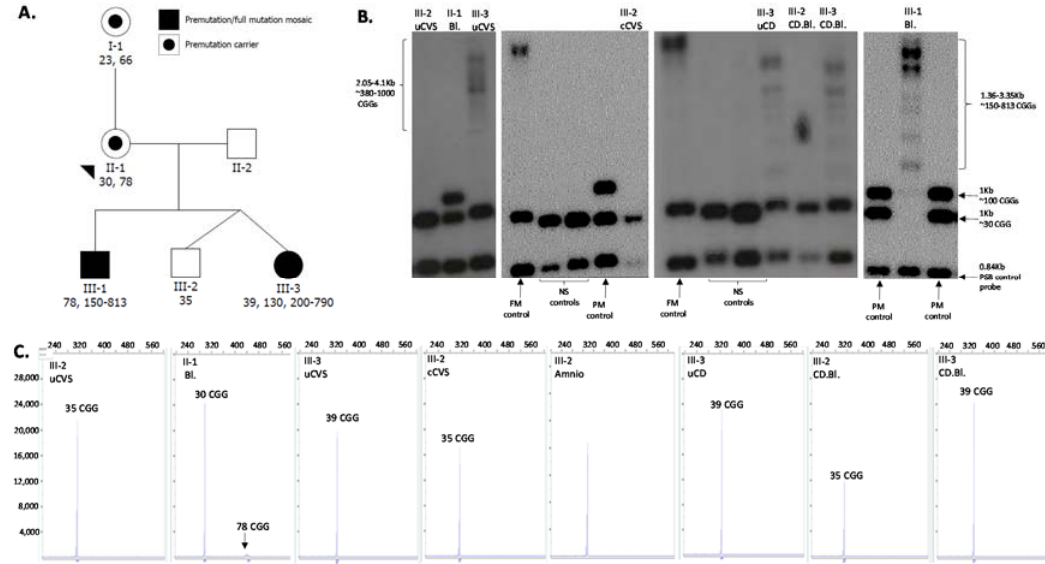
Figure 1. Pedigree and sizing of the CGG repeat using Southern blot and PCR. ( A ) Pedigree of the studied family with squares and circles symbolising males and females, respectively. CGG size is indicated by numbers below each participant’s ID (determined on postnatal tissues); ( B ) Southern blot analysis of the PstI restriction sites (not methylation sensitive) using the FMR1 specific and PBS control probes. ( C ) Capillary electrophoresis sizing using standard PCR, as previously described [8]. NS: normal CGG size (<44 repeats); PM: premutation size (55–199 repeats); FM: full mutation ( ≥ 200 repeats). The x and y axes in panel C represent fragment sizes of bp and fluorescence units of capillary electrophoresis profiles from CGG sizing by standard PCR. uCVS: uncultured chorionic villus sampling; Amnio: amniocyte DNA; Bl: blood DNA; cCVS: cultured chorionic villus sampling DNA; uCD: umbilical cord DNA; CD.BL: cord blood DNA.